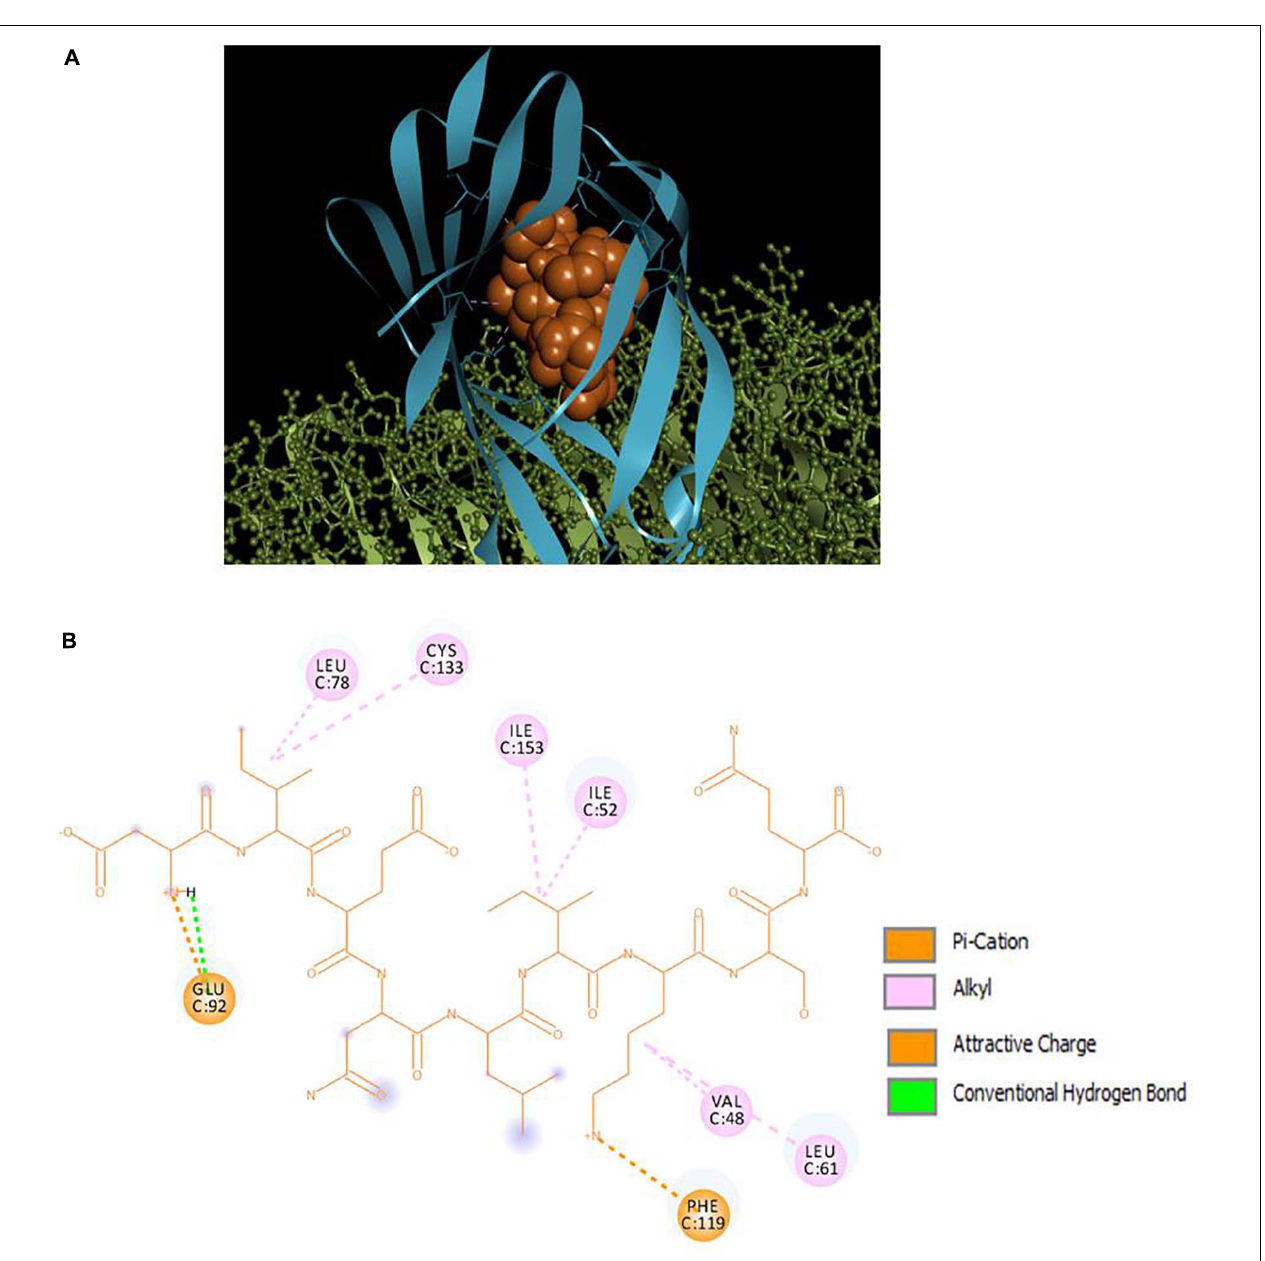
FIGURE 5 | (A) Docking of TLR4 (ball and stick)/MD2 (ribbon) complex with peptide P18 (CPK), (B) 2D representation of TLR4/MD2-peptide interactions. CYS133 is designated as critical to TLR4/MD2-LPS binding.